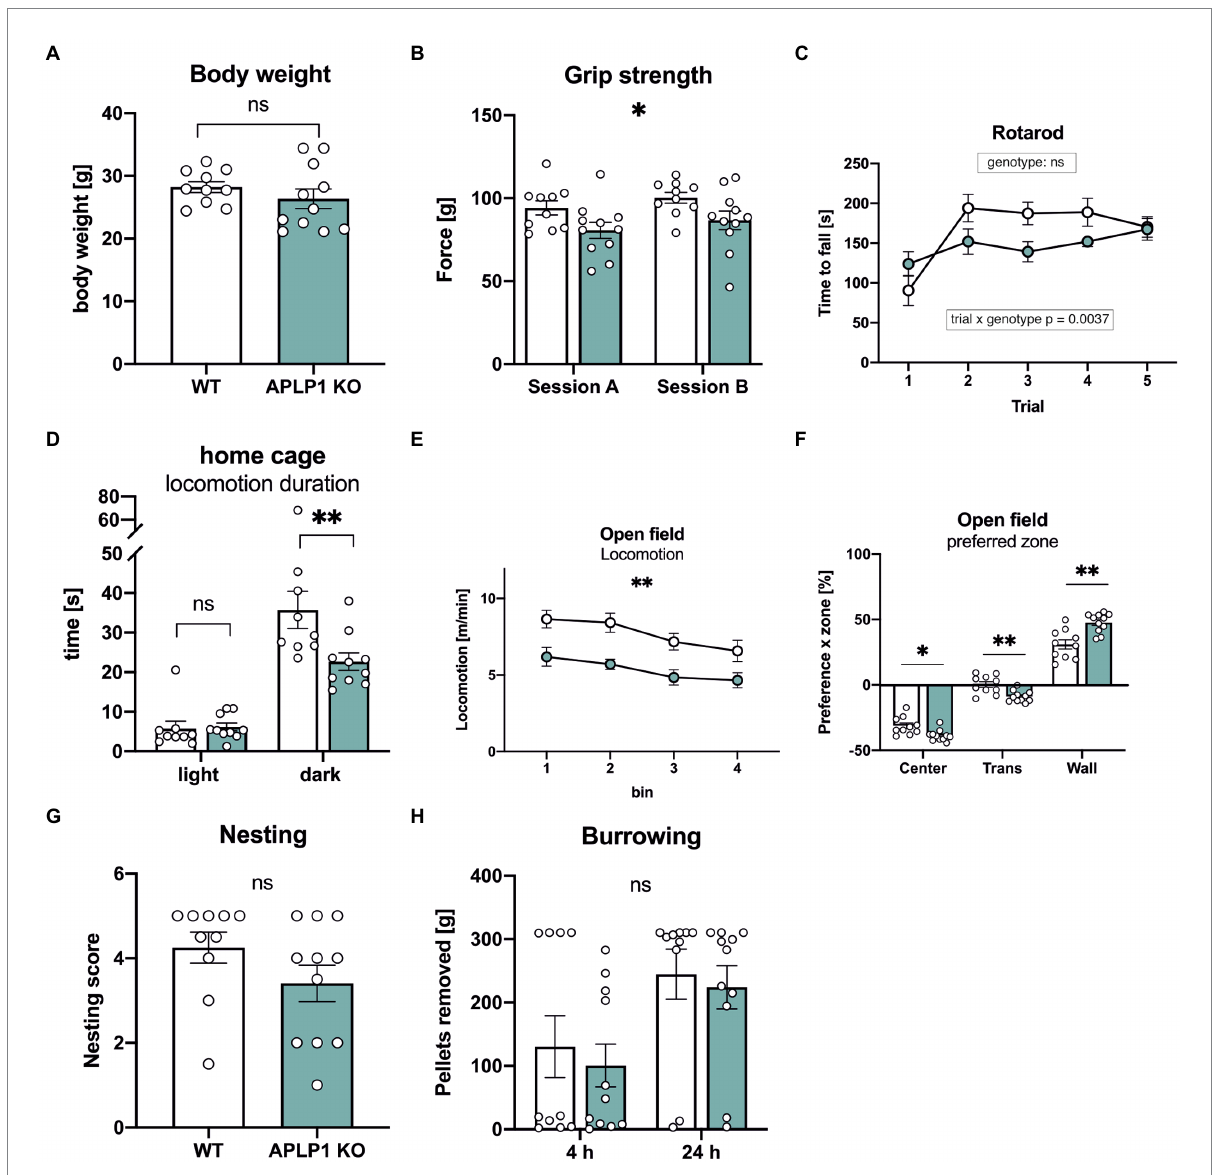
FIGURE 2 APLP1-KOs exhibit small impairments in innate and locomotor behavior. (A) : Bodyweight of APLP1-KOs is not different from wildtype controls (unpaired Student’s t-test, ns p = 0.3272). (B) : Grip force of APLP1-KO animals is slightly reduced comparted to wildtype controls in two test sessions. [geno F (1, 19) = 5.079, p = 0.0362; session F (1, 19) = 5.282, p = 0.0331; session × geno F (1, 19) = 7.387e-005 ns]. (C) : Rotarod performance is comparable between APLP1-KO animals and wildtype controls. [geno F (1, 19) = 1.768 ns; trial F (2.875, 54.63) = 11.18, p < 0.0001; trial × geno F (4, 76) = 4.259, p = 0.0037]. (D) : Locomotion in the home cage. APLP1-KOs showed reduced activity in the dark phase. [geno F (1, 17) = 3.615, p = 0.0743; phase F (1, 17) = 144.8, p < 0.0001; phase × geno F (1, 17) = 12.29, p = 0.0027]. (E) : Open Field activity of APLP1-KOs is reduced